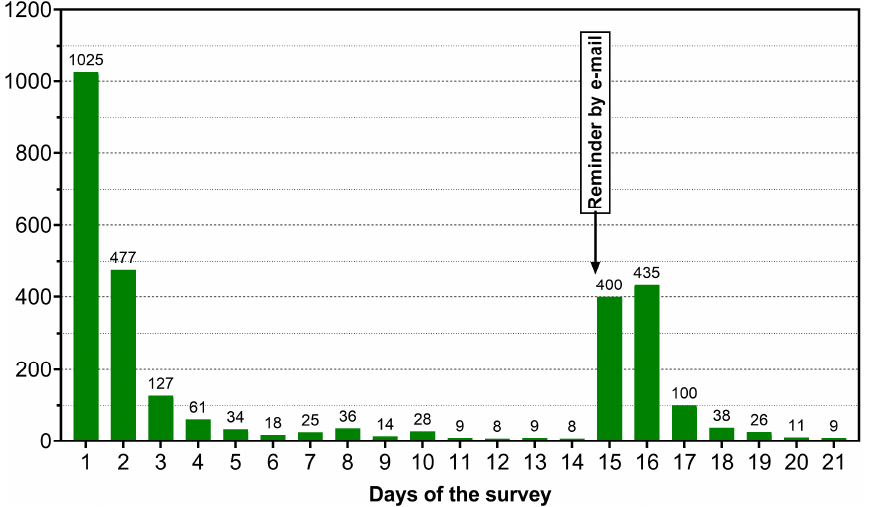
Figure 1. Representation of the number of responses on each of the twenty-one survey days in absolute numbers. The number of responses is plotted above the bars. The time of the reminder six days before the end of the survey was highlighted separately with a text box.